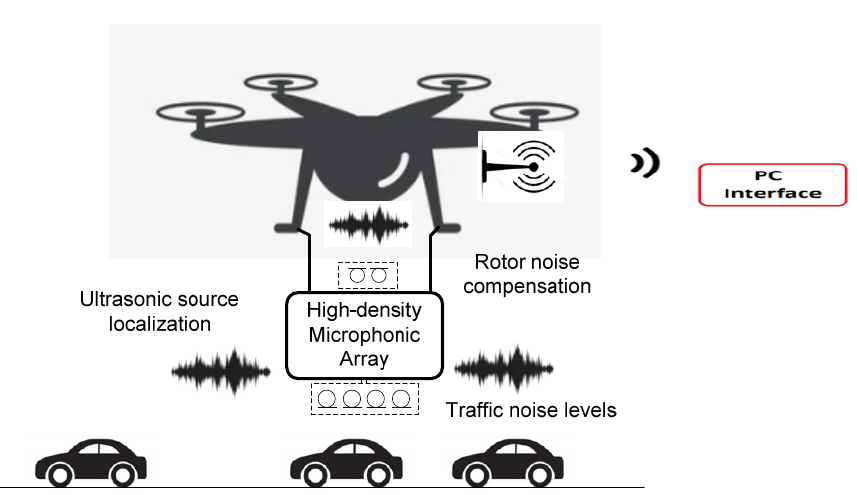
Figure 11. Architecture of the ultrasonic sound localization system using a drone.